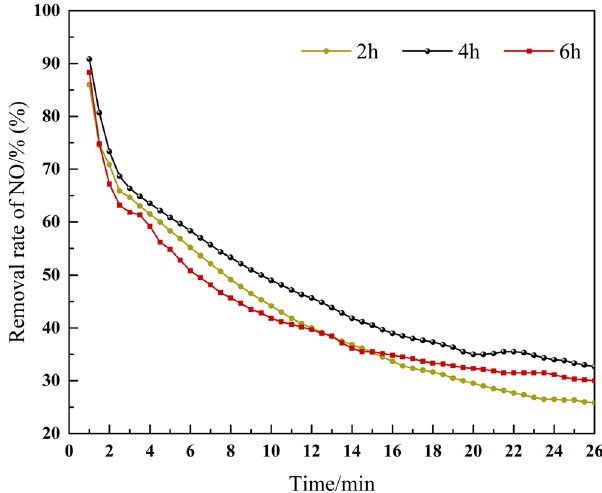
Figure 3. Influence of the sludge with different activation time of LiOH on NO removal efficiency.